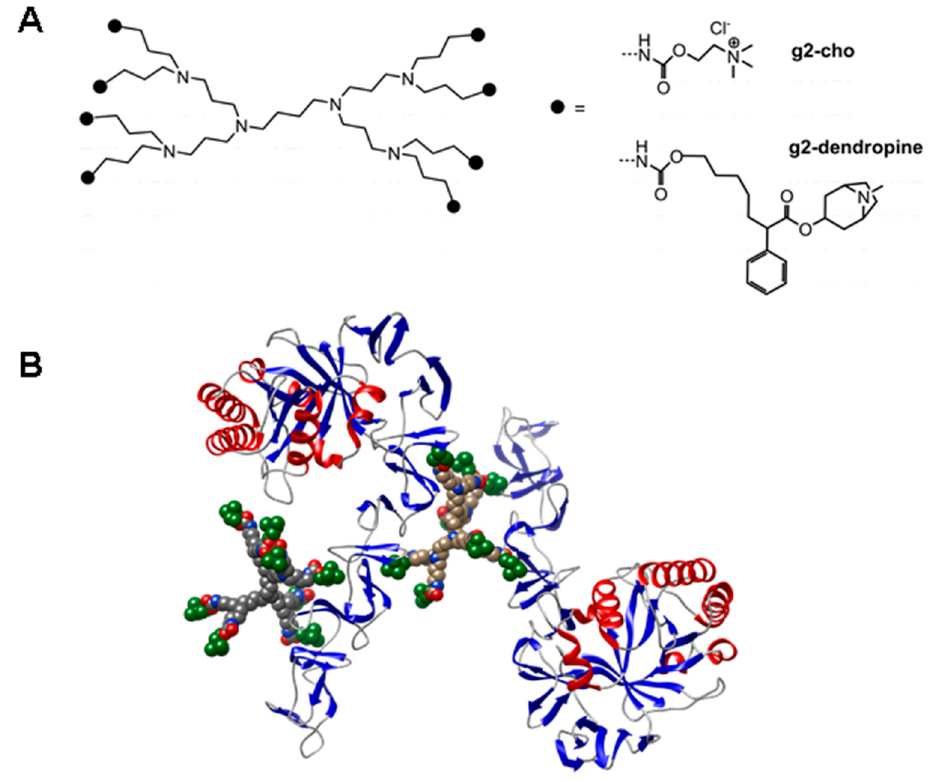
Figure 9. Dendrimeric nanoparticles as inhibitors of CBPs. ( a ) Structure of generation-2 poly(propylene imine) dendrimer functionalized with 8 molecules of choline (g2-cho) or atropine (g2-dendropine); ( b ) A model of the polyvalent interaction between a CBP such as LytB (in ribbon representation) and g2-cho dendrimers (in van der Waals representation). Terminal choline residues are colored